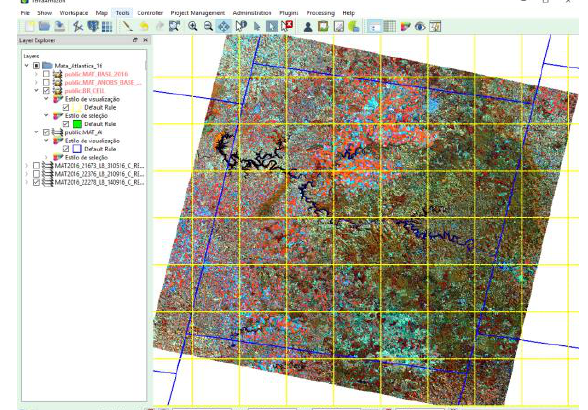
Figure 6. TerraAmazon workspace. Interpreters work within a cell grid (yellow lines), editing only one satellite image cell at a time. Image limits are defined by another grid (blue grid) – in this case Path/Row 222/78 of Landsat-8 OLI (-26.106634; -